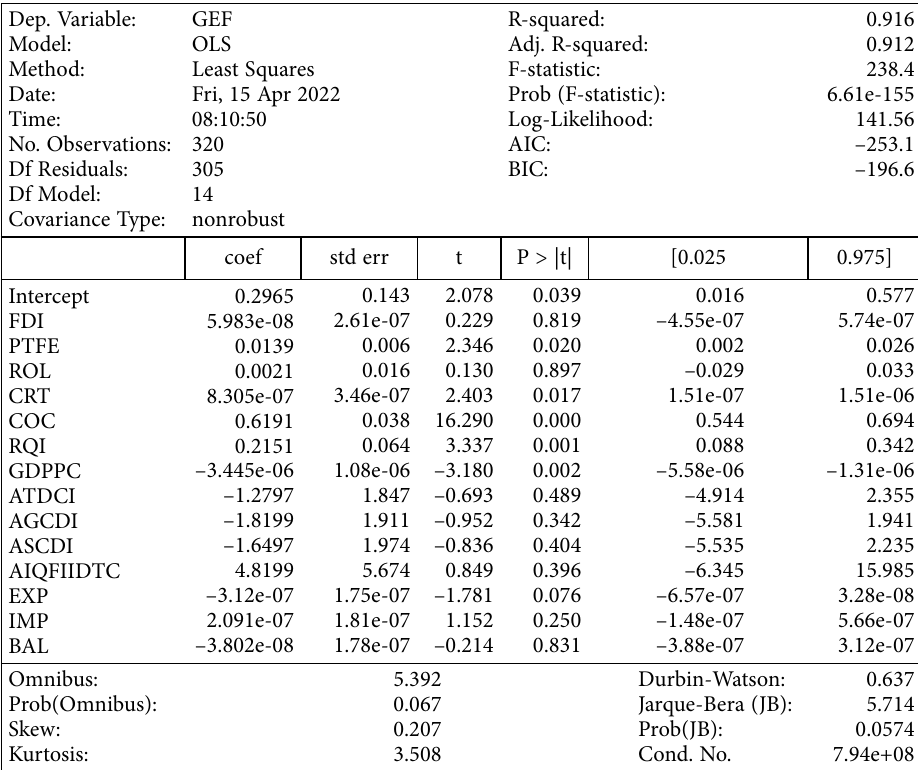
Table 7. OLS regression results – Part 3 (source: own processing using Python 3.0